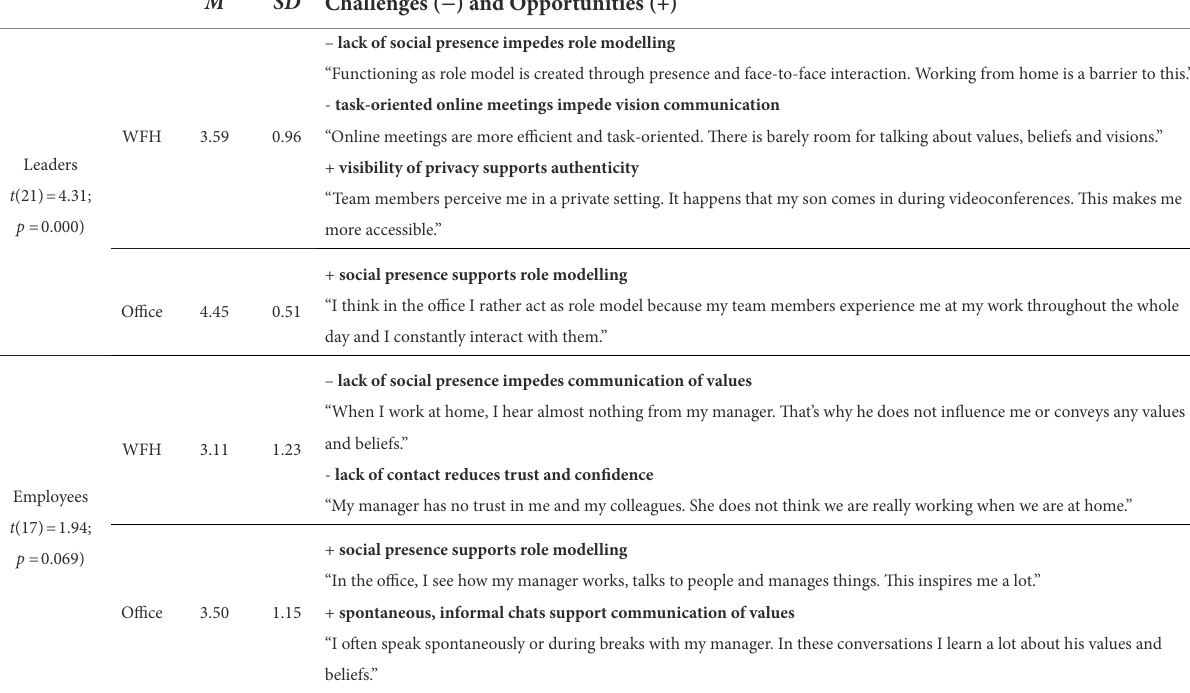
TABLE 1 Challenges and opportunities for idealized